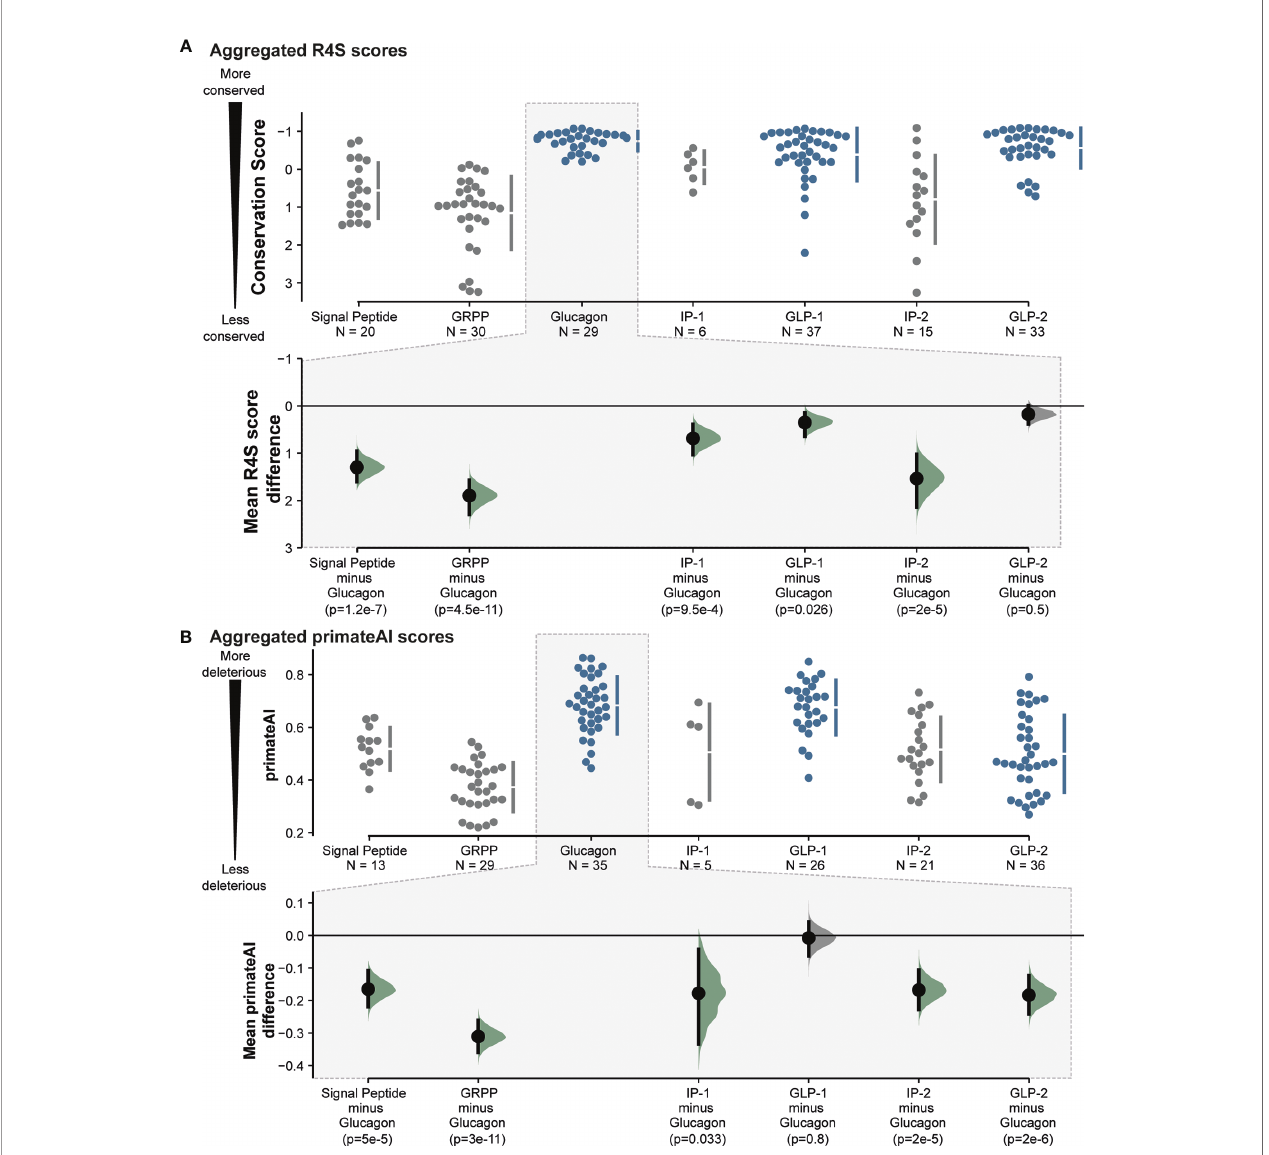
FIGURE 3 | Proglucagon peptide hormones are more conserved and more likely to be severely impacted by missense mutations observed in the human population. (A) . Aggregated peptide mean evolutionary conservation scores from evolutionary trace Rate4Site scores, showing signi fi cant conservation of glucagon, GLP-1 and GLP-2 peptides ( highlighted in blue ). (B) Aggregated primeateAI scores across peptides, indicating higher predicted detrimental effects on glucagon, GLP-1 and GLP-2 peptide hormones. Mean difference analysis ( bottom ) from dabest (50) comparing other peptides to glucagon. P-values were calculated by a nonparametric Mann – Whitney test and distributions have been highlighted in green if below 0.05. See SI2 for more detailed